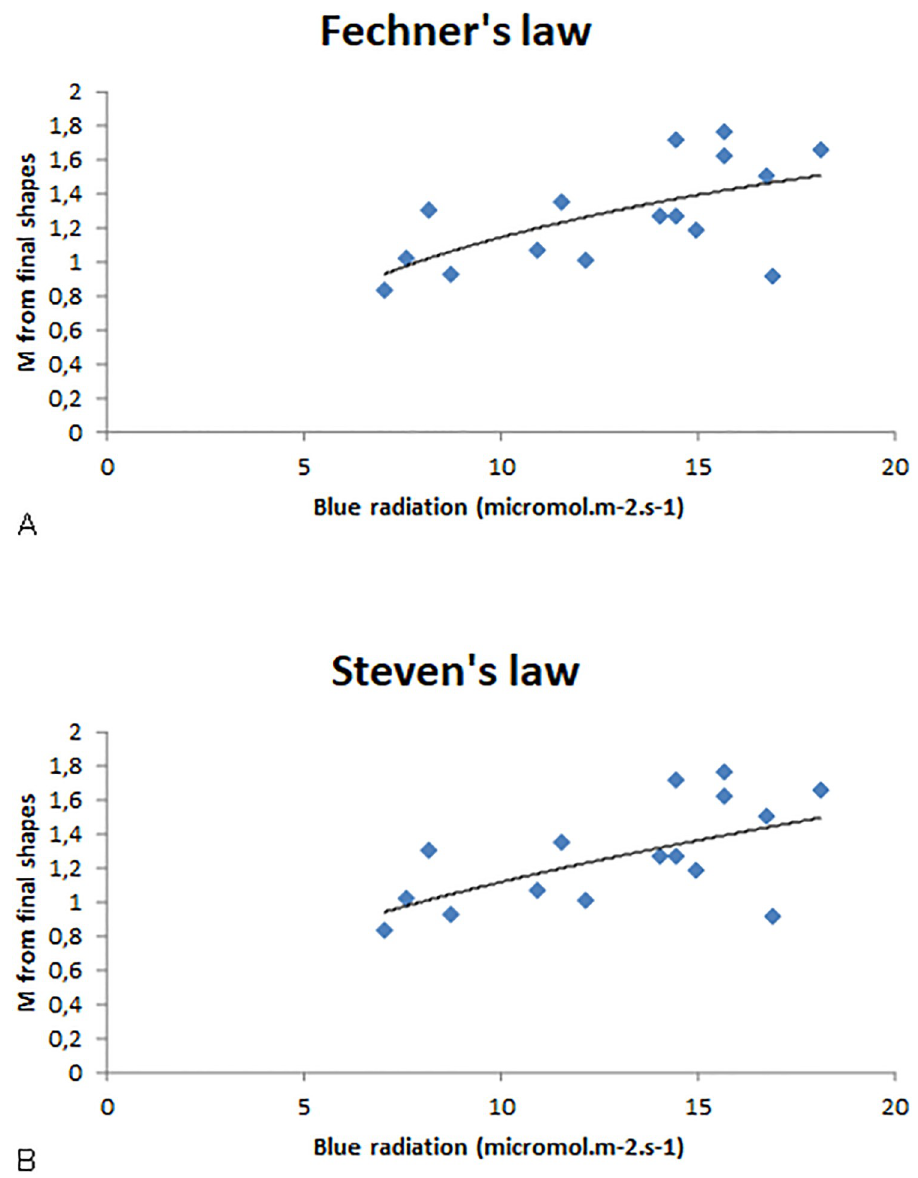
Fig 11. M values as a function of blue light intensity for oak. A: Fechner’s law: M values are fitted by a logarithmic function: y = 0.6253 ln( x ) − 0.2899; R 2 = 0.2848. B: Steven’s law: M values are fitted by a power function: y = 0.287x 0,0.579 ; R 2 = 0.3415. Two outliers were removed from the plots.